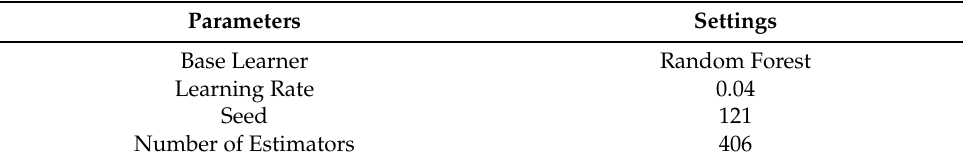
Table 3. Model Parameters for AdaBoost-Random Forest for ACP